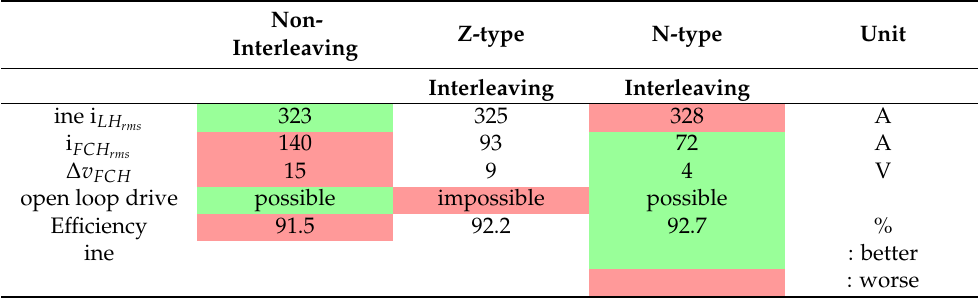
Table 4. Performance comparison table according to the interleaving